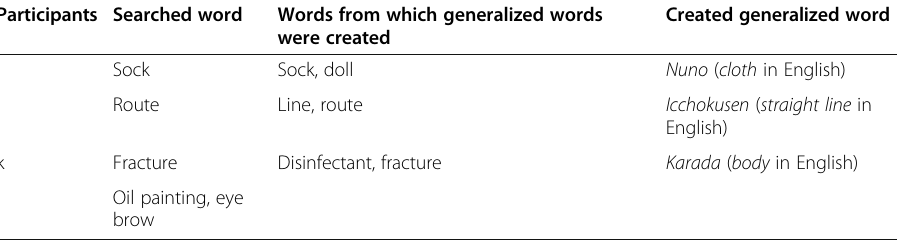
Table 11 Searched words, generalized word, and words used to create generalized words Participants Searched